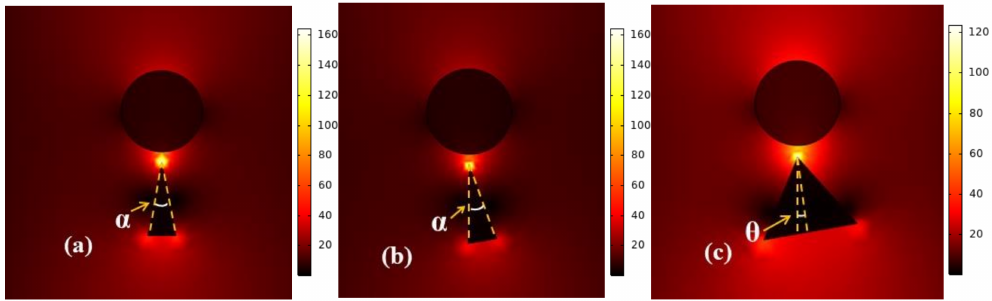
Figure 4. 2D electric field distribution under different vertex angle of triangle silver and rotation